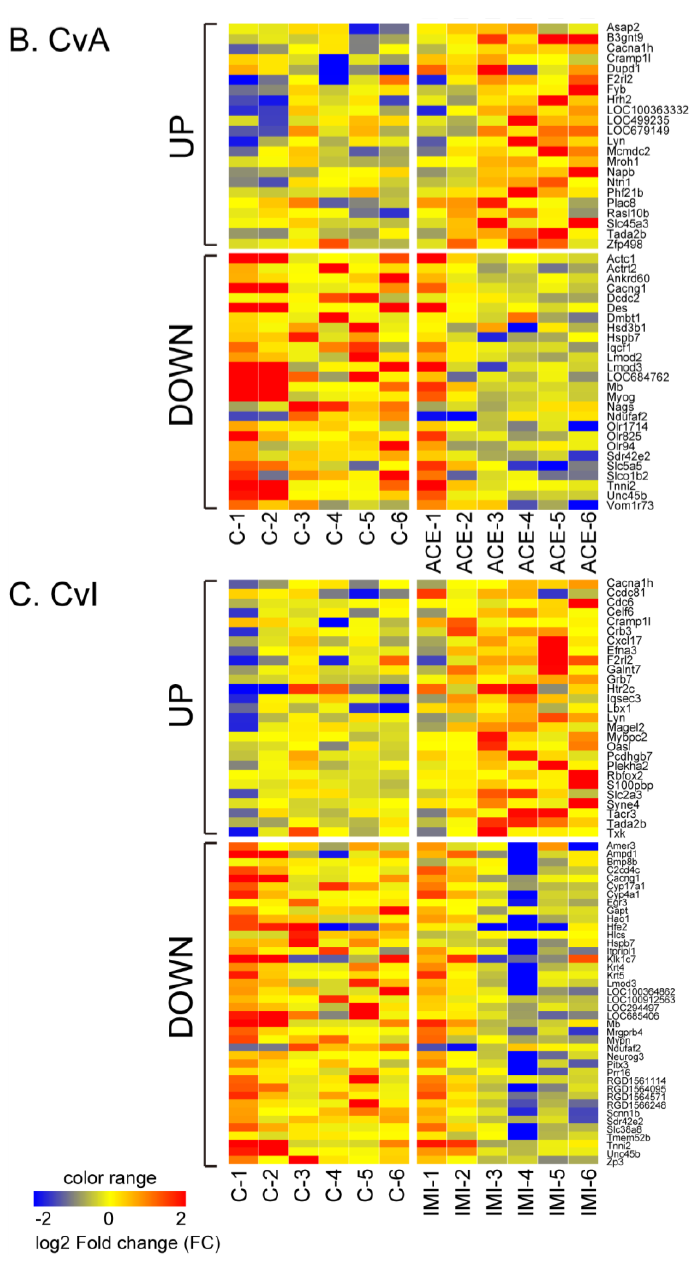
Figure 4. Heat maps of differentially expressed for control versus NIC ( A ), ACE ( B ), or IMI ( C ) (CvN, CvA, and CvI, respectively) from each of the six experiments (x-axis). Gene probes are listed alphabetically on the y-axis. Color change represents magnitude of log 2 fold change (−2 (blue) to 2 (red)).